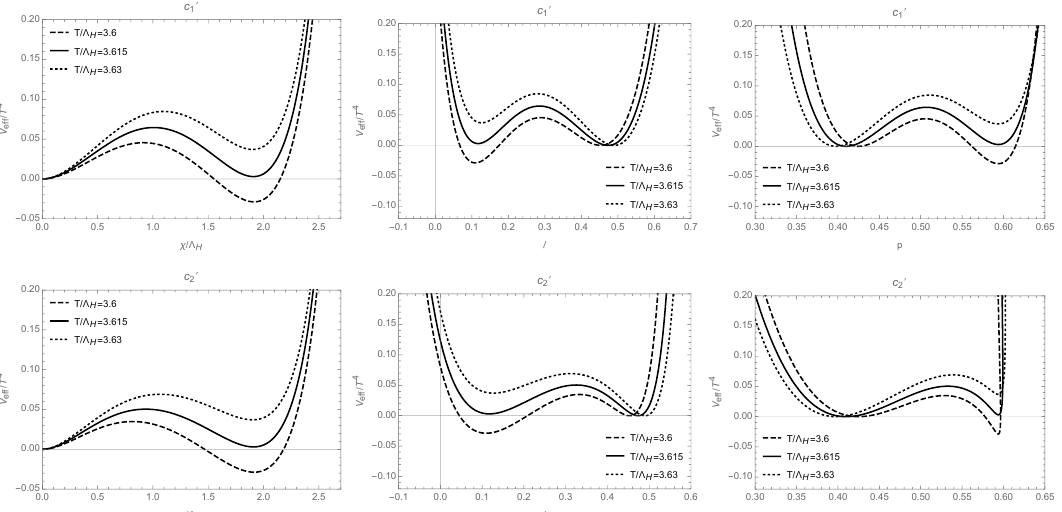
(red) and c 0 (blue) linking the two minimum points given 1 2